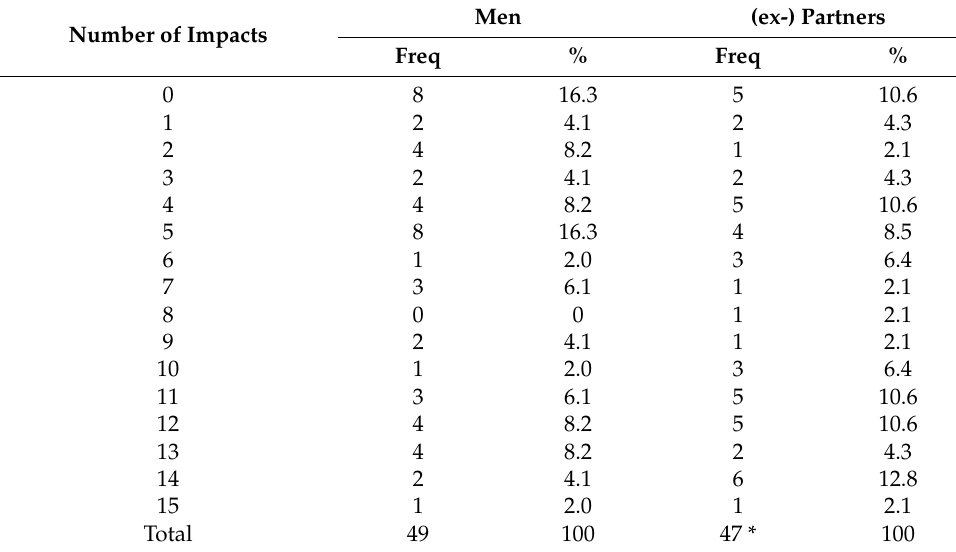
Table 6. Number of impacts reported by men and (ex-) partners. Number of Impacts